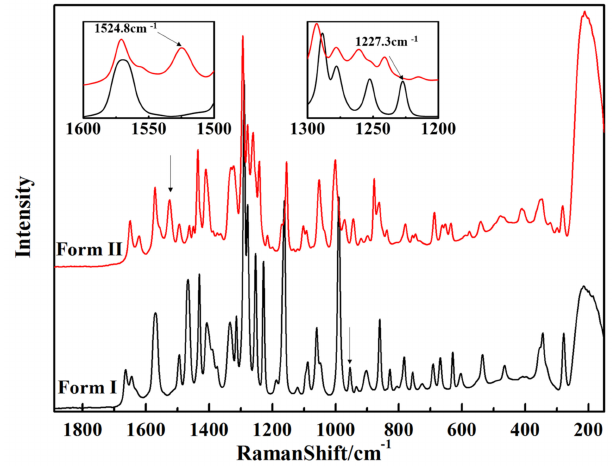
Figure 5. Thermal analysis curves of L-carnosine form I and form II: ( a ) differential scanning calorimetry; ( b ) thermogravimetry.